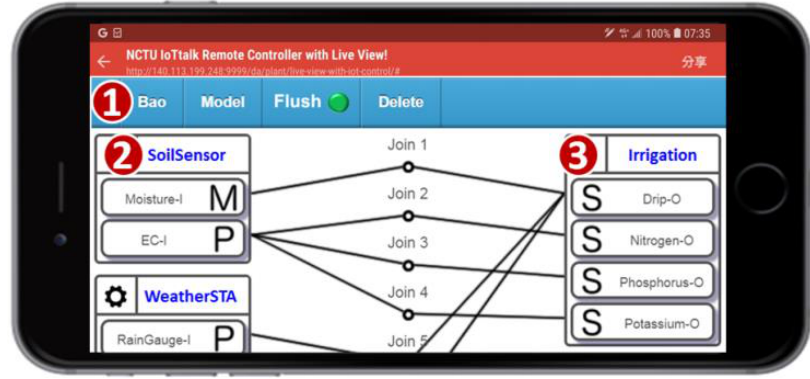
Figure 2. AgriTalk GUI for connecting IoT devices. Through the Join links, AgriTalk